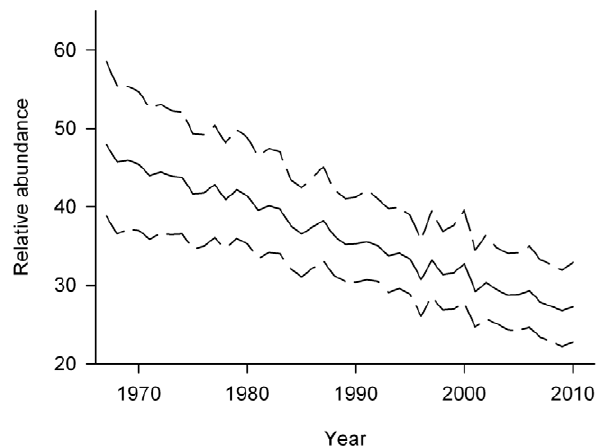
Figure 1. Temporal trend of cowbird abundance in Missouri, 1966–2010. Data are from the North American Breeding Bird Survey [15]. Dashed lines indicate 95% credible intervals.